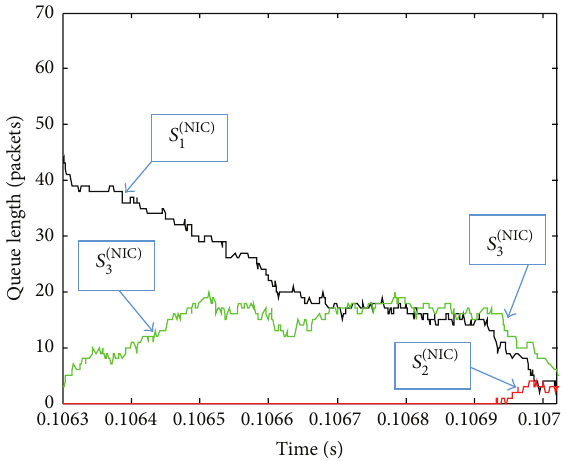
Figure 4: Lenght evolution of the NIC queues.